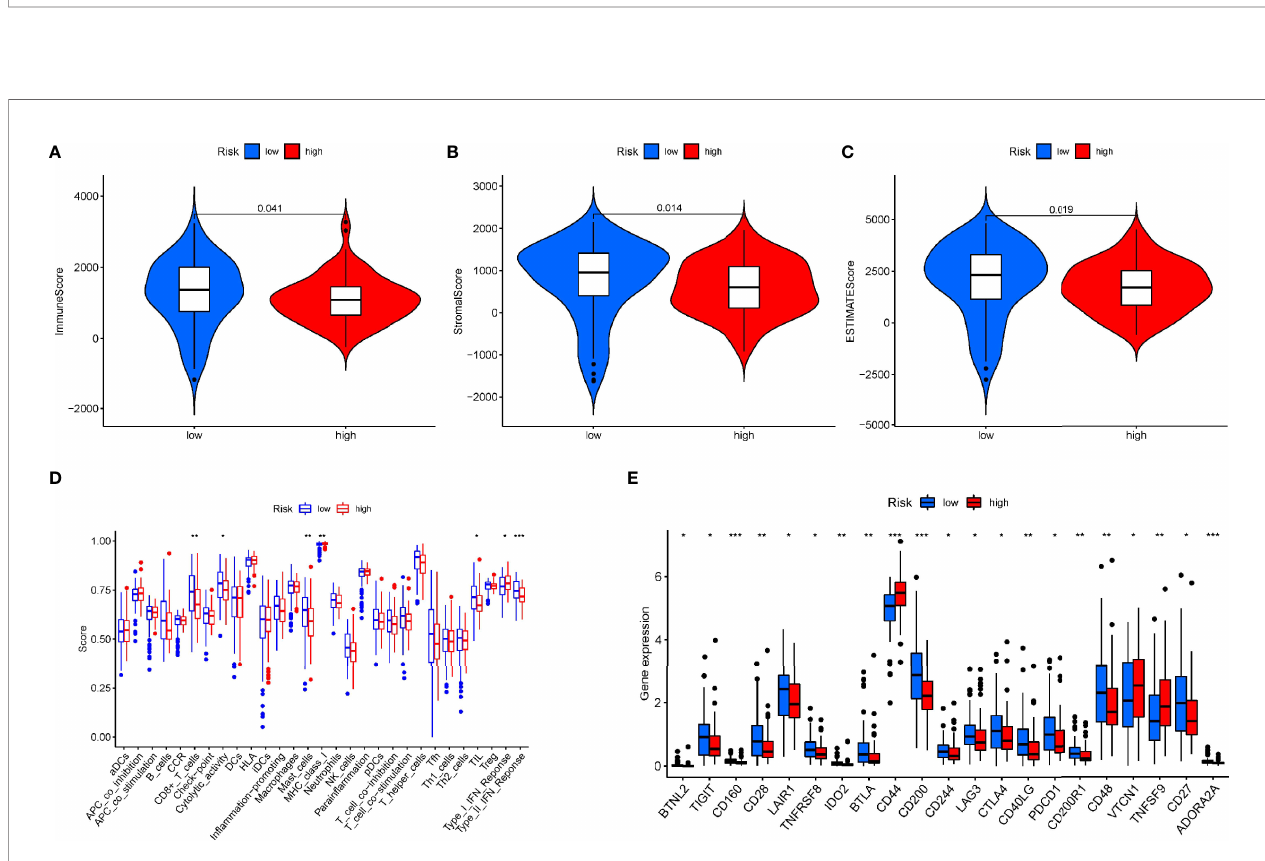
FIGURE 7 | The relationship of the prognostic signature and immune cell in fi ltration in PAAD. (A-C) The immune score and stromal score in high and low risk group. (D) Comparison of the enrichment scores for immune cells and immune-related pathways between low- and high-risk group. (E) The differential expression of immune checkpoint between high-risk (red box) and low-risk (blue box) group in PAAD. *p < 0.05; **p < 0.01; ***p <